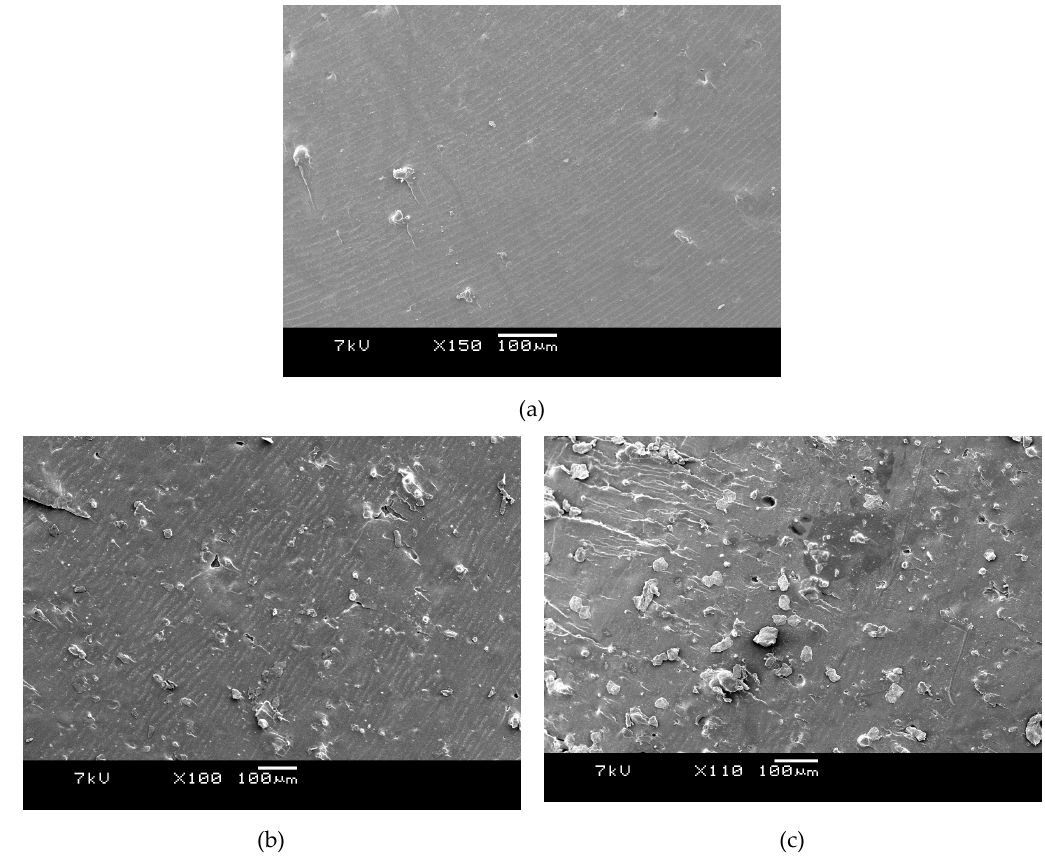
Figure 7. SEM images of nano-Al 2/PET composites ( a ) 1 vol. % Al 2 ( b ) 3 vol. % Al 2 ( c ) 5 vol. % Al 2. There are a lot of fine particles but agglomerates as large as 50 µm can be seen. There are very few drop-outs (dark cavities).